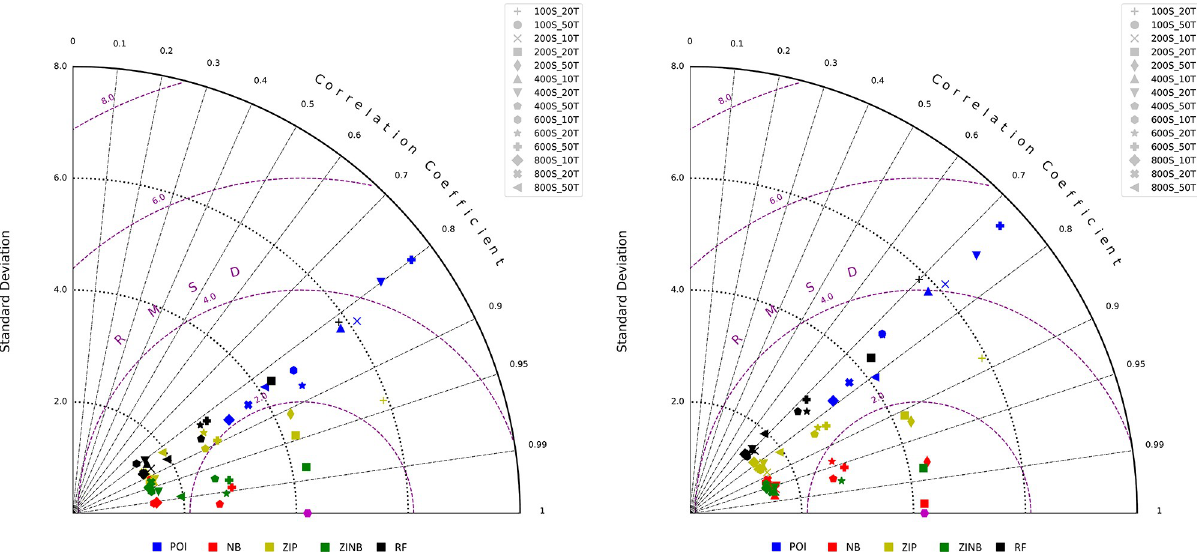
Fig 7. Modified Taylor diagrams showing the performance of the models based in three metrics: Standard deviation, RMSD, and a correlation coefficient (left: Spearman’s, right: Kendall Tau), which are represented by the Y, circular, and radial axes, respectively. Each of the colored symbols represents an ensemble with a concrete number of tree estimators (T) and samples per leaf node (S). Using the pink hexagon as a reference, we can see that the models better performing are located under the arc created by RMSD = 2, since they present a high Pearson/Kendall coefficient, low RMSD, and a standard deviation close to the raw tick bites per grid cell (i.e. stdev = 3.15). Out of these selected models, we can see that 2 ZIP and 1 ZINB models present a higher skill to model overdispersion (i.e. std. dev. > 4), whereas the small cluster of NB and ZINB models under the arc are better suited to predict zero-inflation. As seen, experiments with in the range of 200–600 samples per leaf node seem to perform optimally in both diagrams.